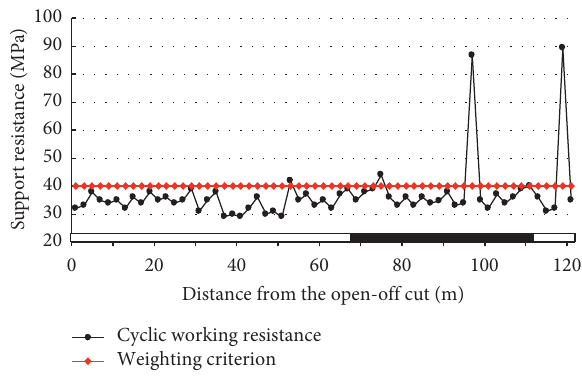
Figure 5: Resistance of support in simulated working face.